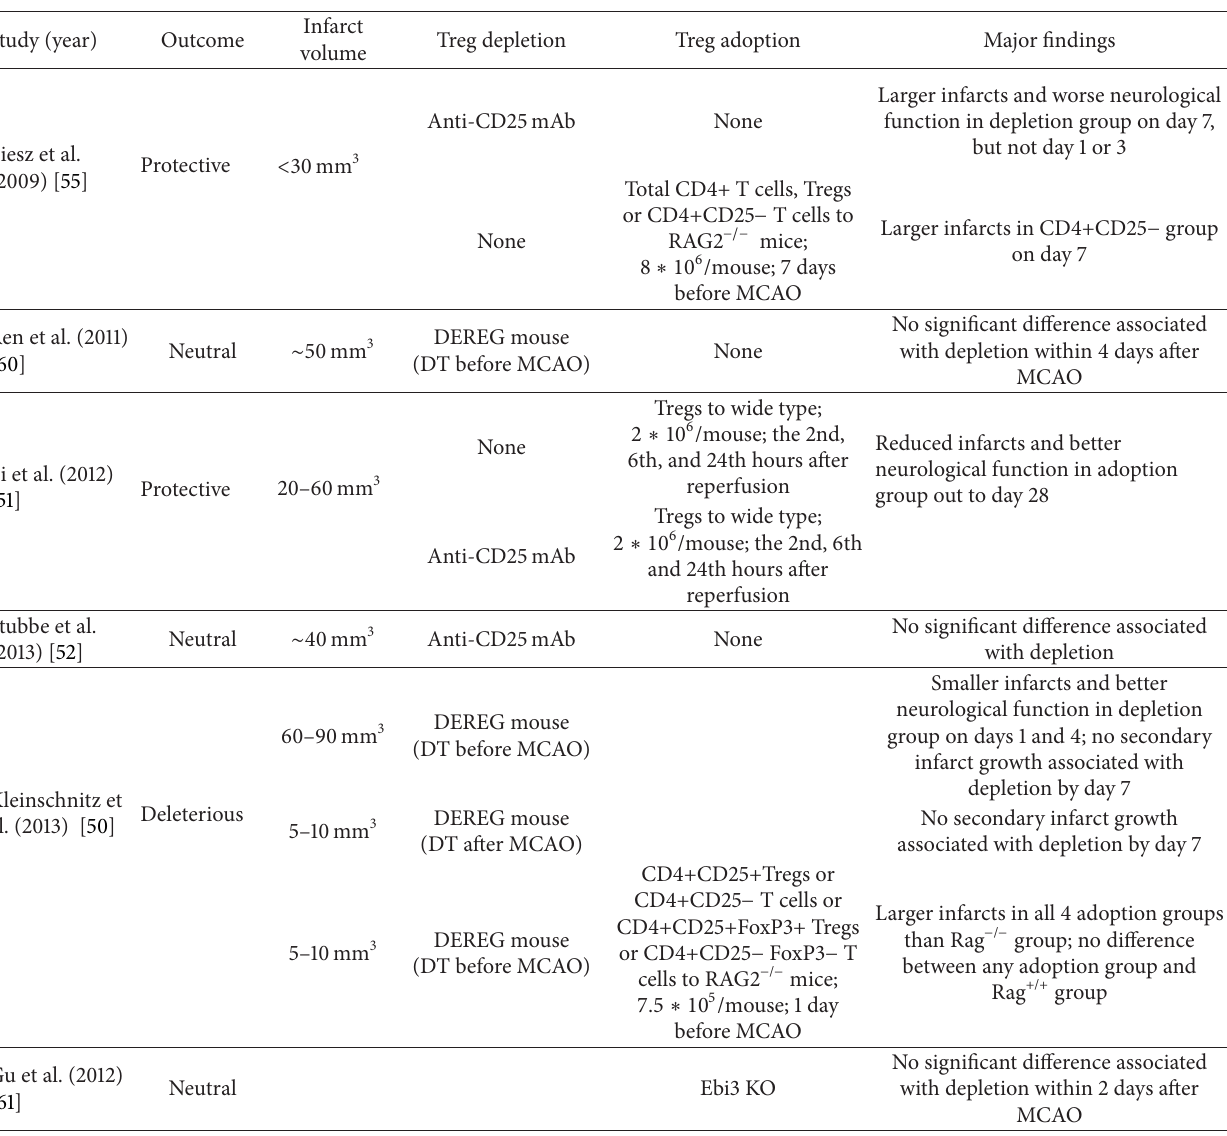
Table 1: Outcome of current studies in murine